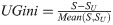
Correlation dot plots between different variants of the Gini index analyzed in this paper.Left: Correlation between the unambiguous standardized Gini index obtained as UGini=S−SUMean(S,SU), where Su = 0.6091 denotes the standard deviation of the log-normal distribution with Gini index Gu. and the log of the raw Gini indices. Right: Agreement of the original raw Gini index and the Gini index resulting from back transformation of the UGini parameter. The Fig has been created using the R software package (version 3.4.0 for Linux; http://CRAN.R-project.org/ [18]).